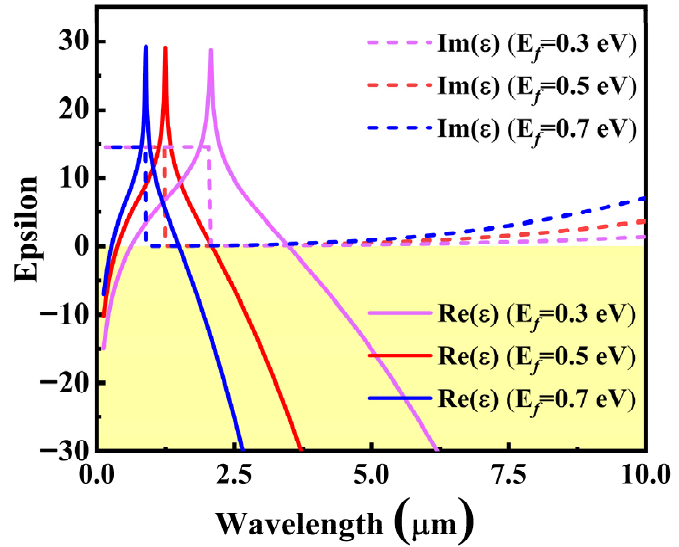
Figure 2. Representative behavior of the DSM dielectric functions. The solid line and the dash line represent the real and imaginary parts of the DSM, respectively. The parameters are set as ε b = 1, g = 40, ε c = 3, v f = 10 6 m/s, τ = 4.5 × 10 − 13